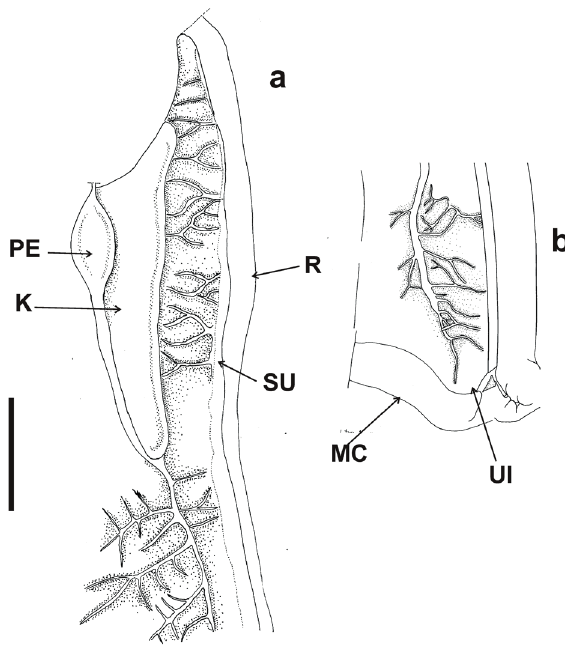
Figure 4 - a , proximal portion of pallial system of Solaropsis brasiliana . Kidney (K); pericardium (PE); rectum (R); secondary ureter (SU). (Scale bar= 5 mm); b , distal portion of pulmonary roof showing union with mantle collar (MC) and ureteric interramus (UI). Scale bar=